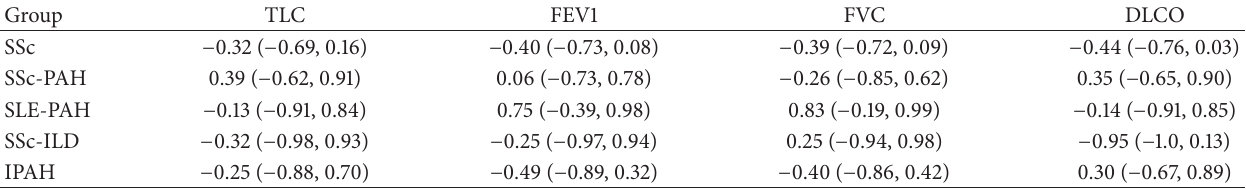
Table 4: Correlation between alveolar NO ( 𝐶 𝐴 NO) and pulmonary function testing.